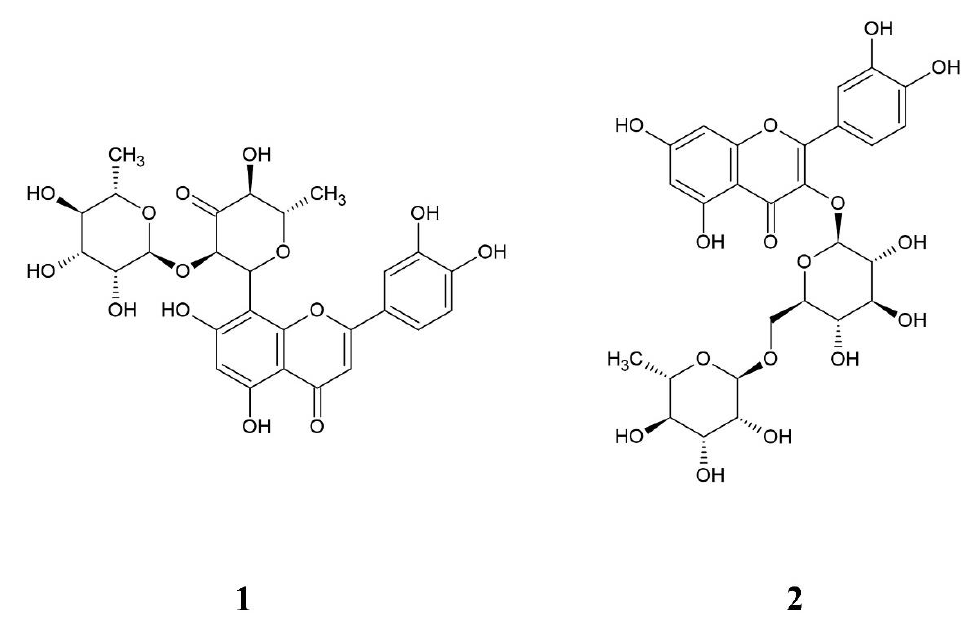
Figure 1. Chemical structure of hepatodamianol ( 1 ) and rutin ( 2 ).